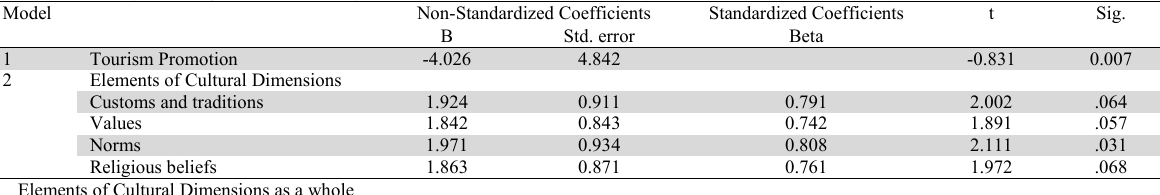
The summary of regression